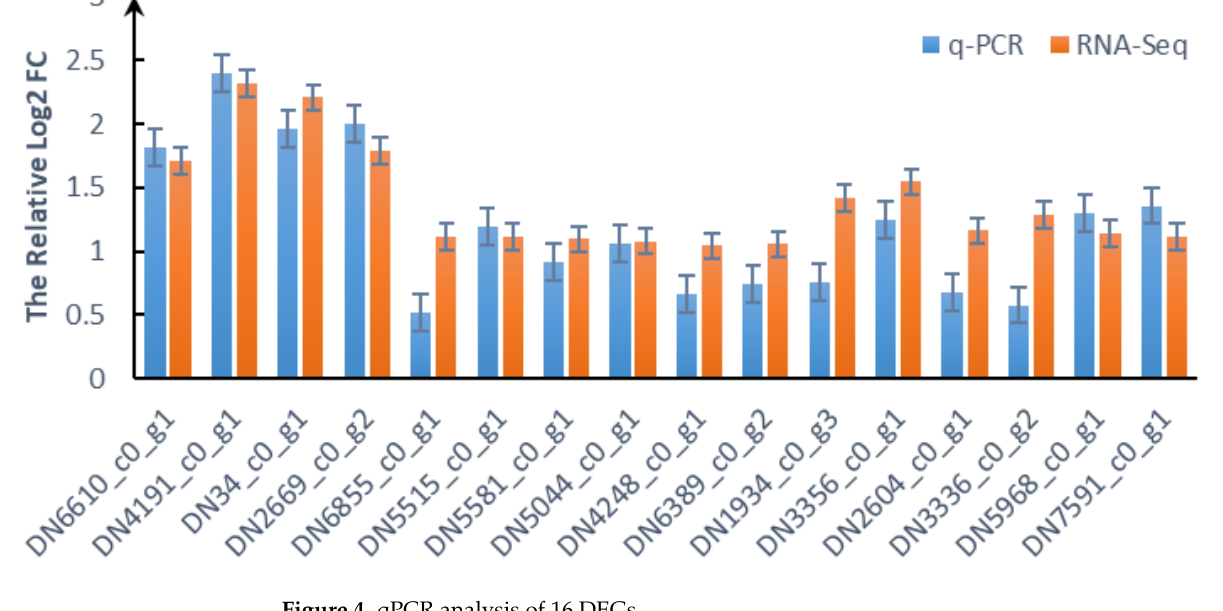
Figure 4. qPCR analysis of 16 DEGs.